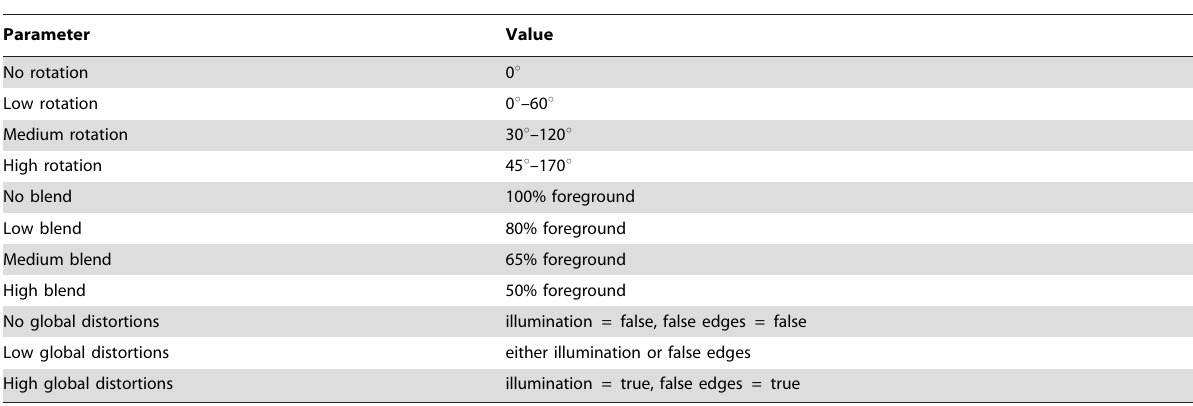
Table 1. Range of Parameter values.